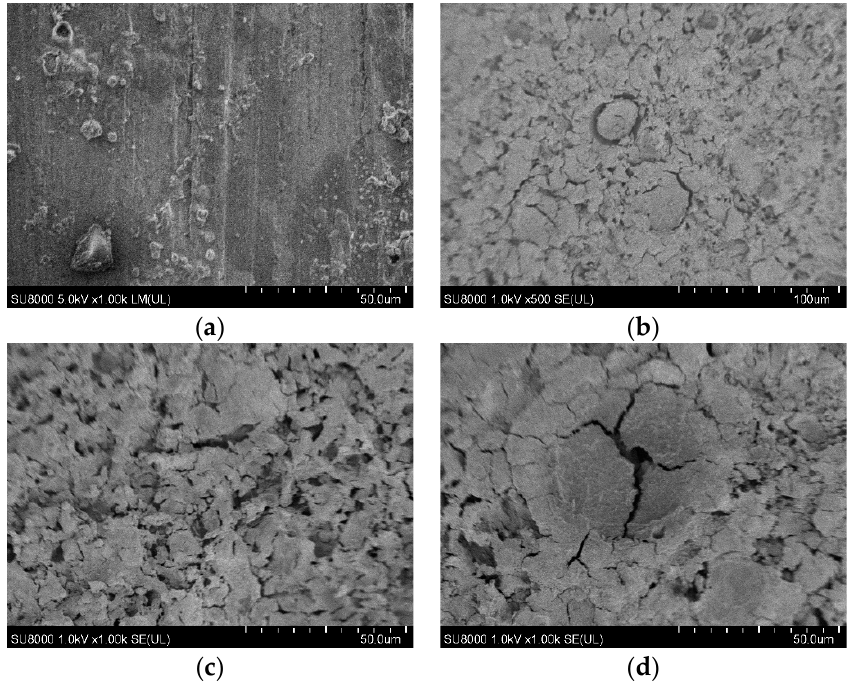
Figure 4. Microscopic corrosion morphology of hanging piece under different CO 2 partial pres-